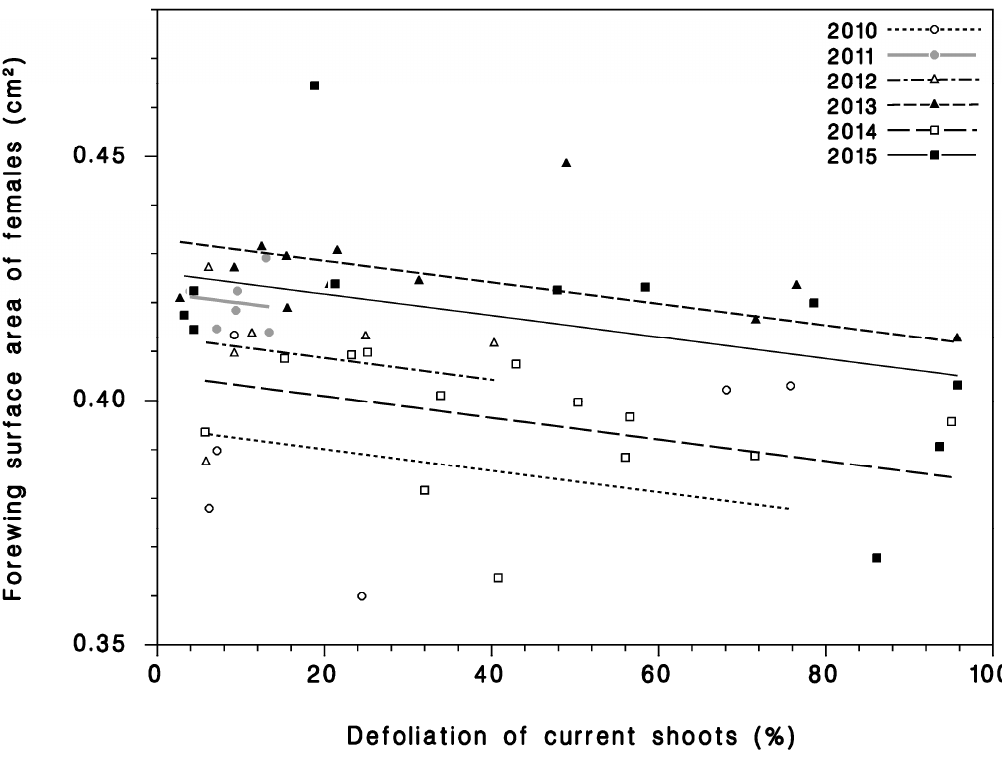
Figure 2. Effect of year and current-shoot defoliation on forewing surface area among female moths caught in light traps in the lower St. Lawrence region, 2010–2015. Lines are linear least-squares regressions fitted to the observations available for each year.